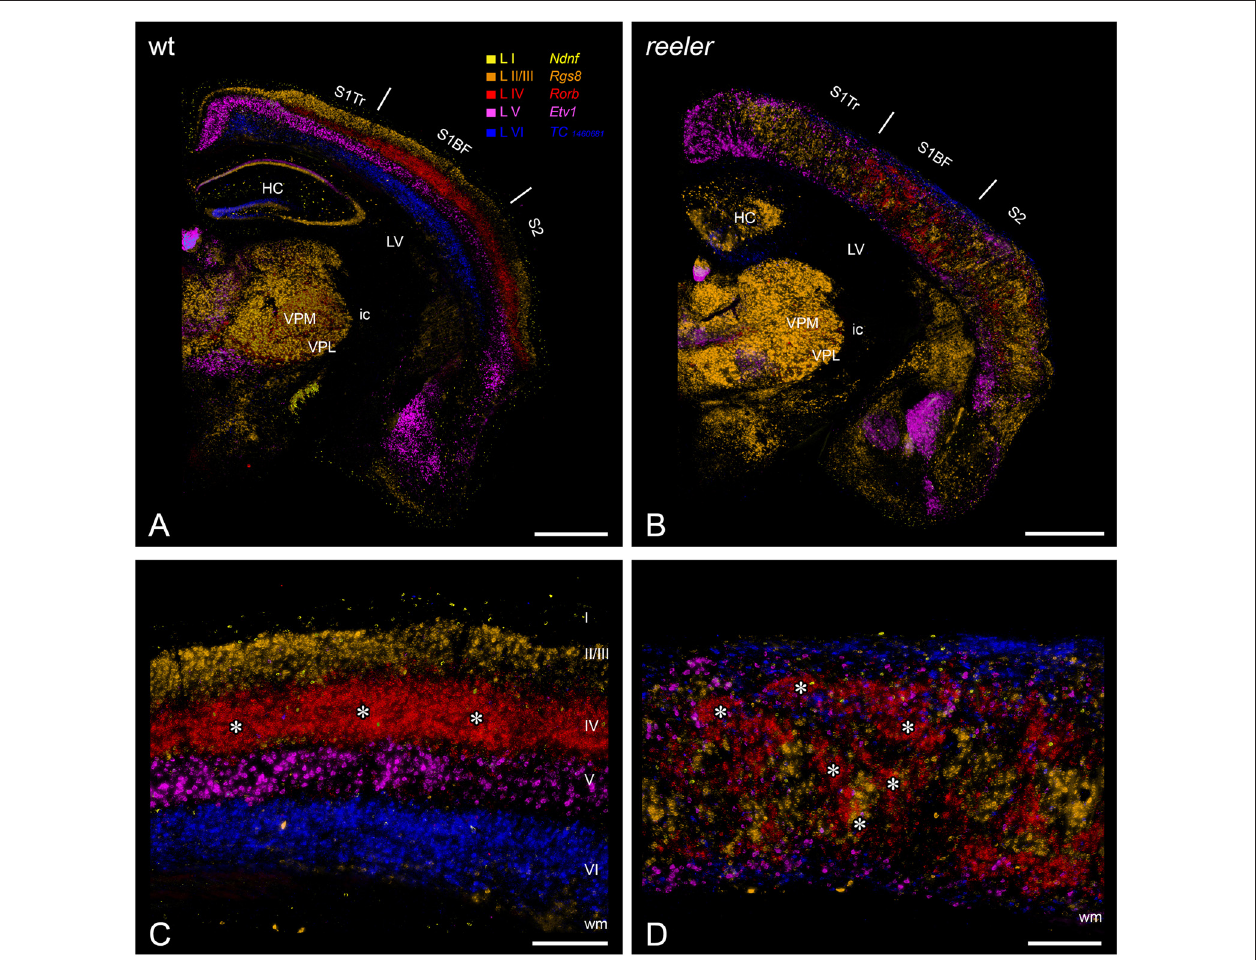
FIGURE 1 | Laminar fate markers show the dramatic disorganization of cortical layers in the reeler brain. (A,B) Coronal hemisections through the brain of a wild type (A) and a reeler mouse (B) , at the level of the primary somatosensory (barrel) cortex. Laminar fate markers (labeled in A ) have been stained by in situ -hybridization in serial sections, false color-coded and overlaid to obtain a comprehensive impression (modified from Wagener et al., 2016). The overview shows that the general anatomical layout of the brain in terms of subcortical nuclei and cortical areas is basically normal. (C,D) Higher magnification through the barrel cortex shows a typical layering of a granular cortex (C) , with barrel-like clustered L IV-spiny stellates ( asterisks ). In the reeler mutant (D) , most cell types can be found anywhere across the cortical depth, with L IV-fated cells also forming cluster, which we called barrel equivalents ( asterisks ). Roman numerals mark cortical layers. Abbreviations: HC, hippocampus; ic, internal capsule; LV, lateral ventricle; S1BF, barrel field of the primary somatosensory cortex; S1Tr, trunk region of the primary somatosensory cortex; S2, secondary somatosensory cortex; VPL, nucleus ventralis posterolateralis; VPM, nucleus ventralis posteromedialis. Scale bars: (A,B) —1000 µ m; (C,D) —250 µ